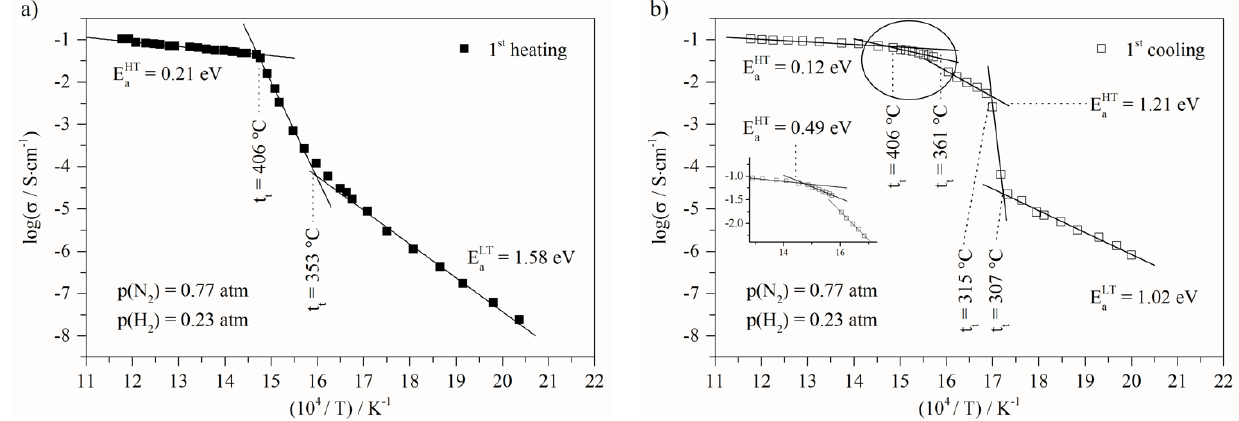
Figure 3. Focus on the first cycle: two Arrhenius diagrams in dry 23%—H 2 —in—N 2 for SDC—LiNaK composite electrolyte: ( a ) heating and ( b ) cooling. Activation energy values were obtained within low (E aLT ) and high (E aHT ) temperature regions of diagrams. Transition temperatures are defined by t t .